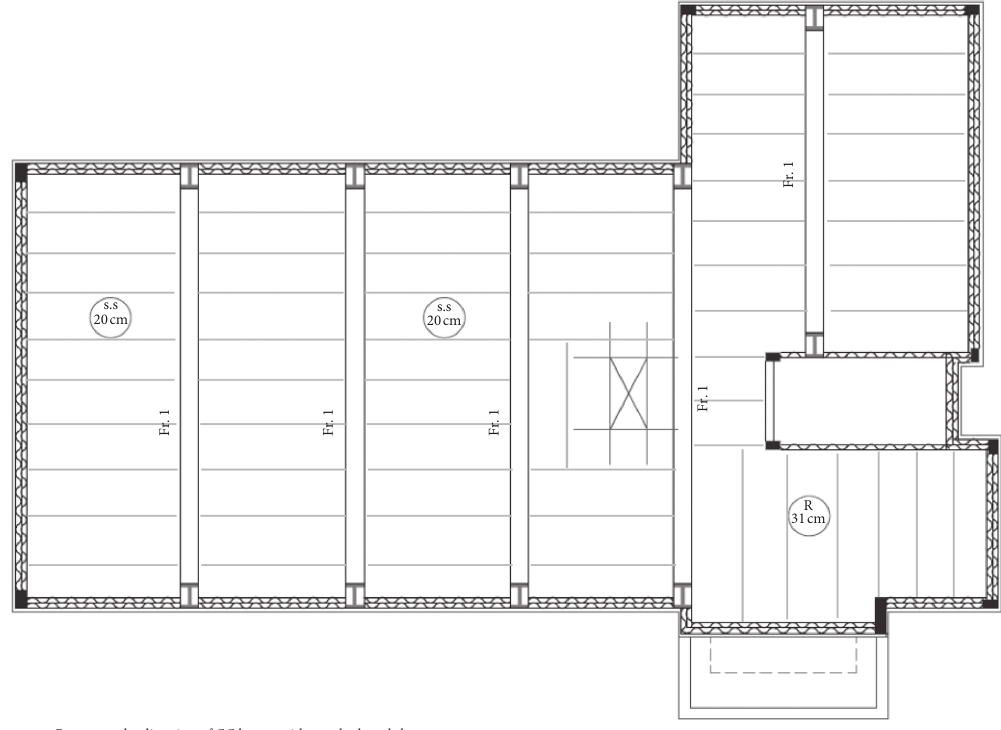
Figure 24: Contour crafting